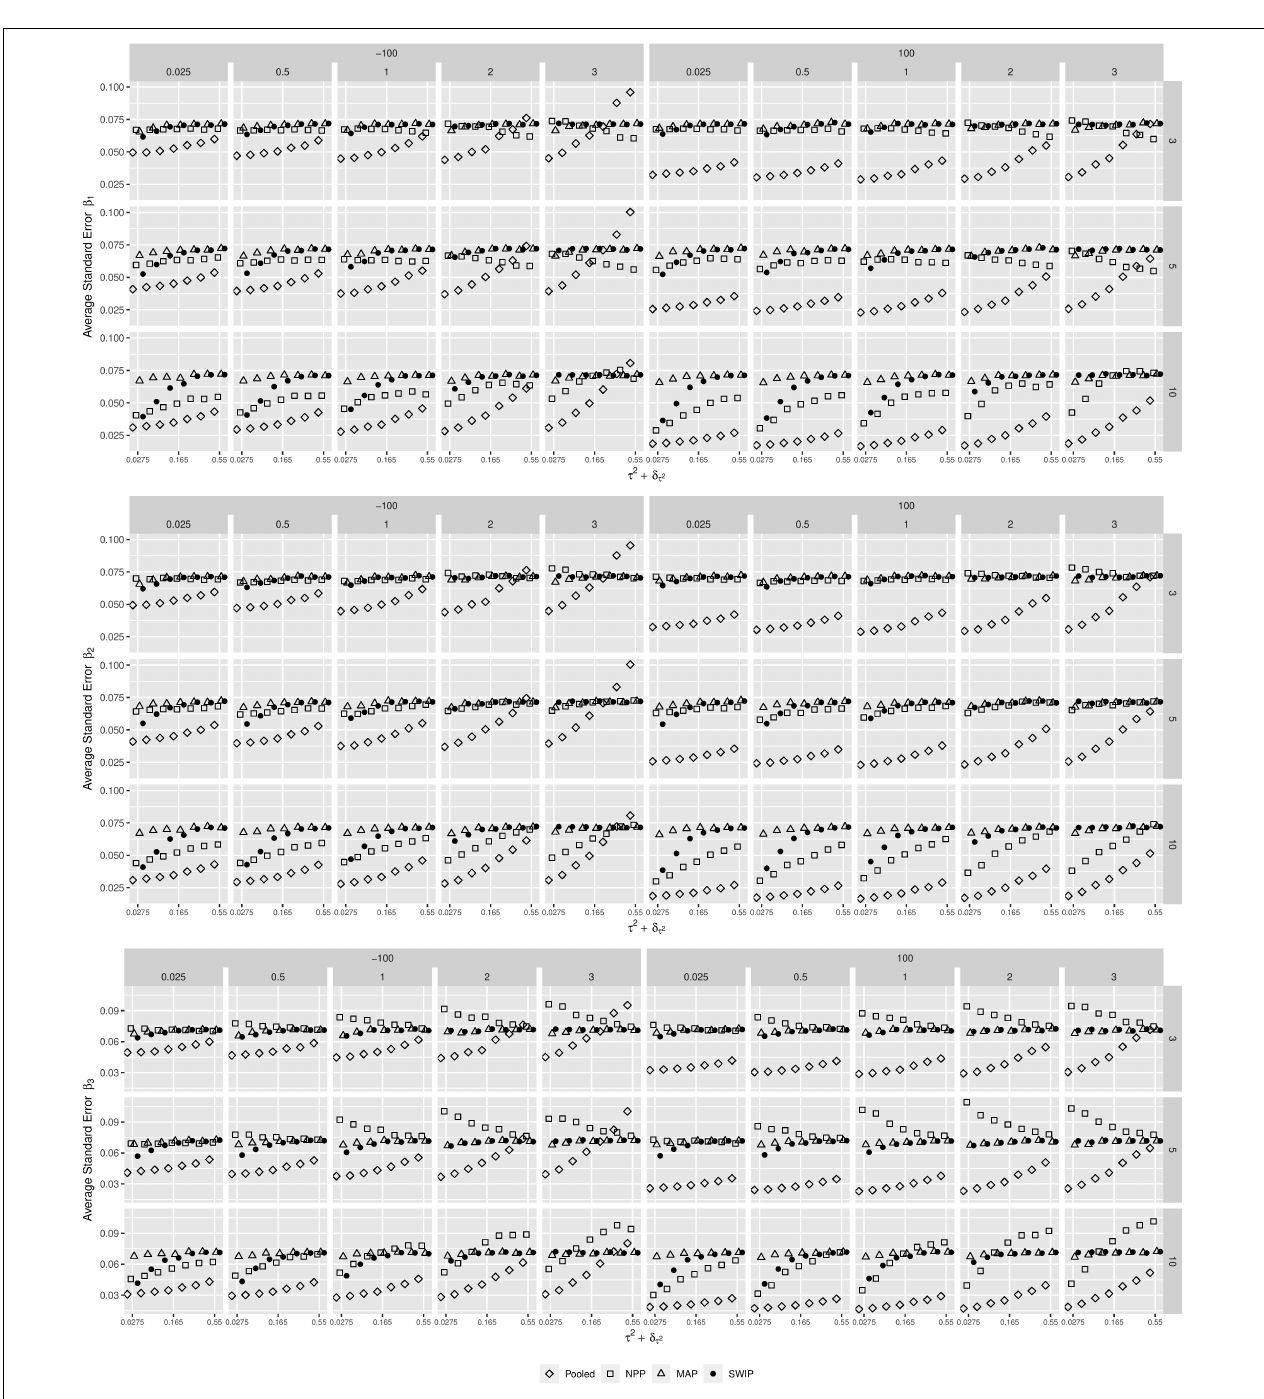
FIGURE 3 | The behavior of the standard errors of the parameter estimates across simulation conditions. The similarity of the focal and the previously conducted studies decreases from left to right . Pooled = pooled Bayesian analysis; NPP = normalized power prior; MAP = meta-analytic predictive prior; SWIP = similarity-weighted informative prior